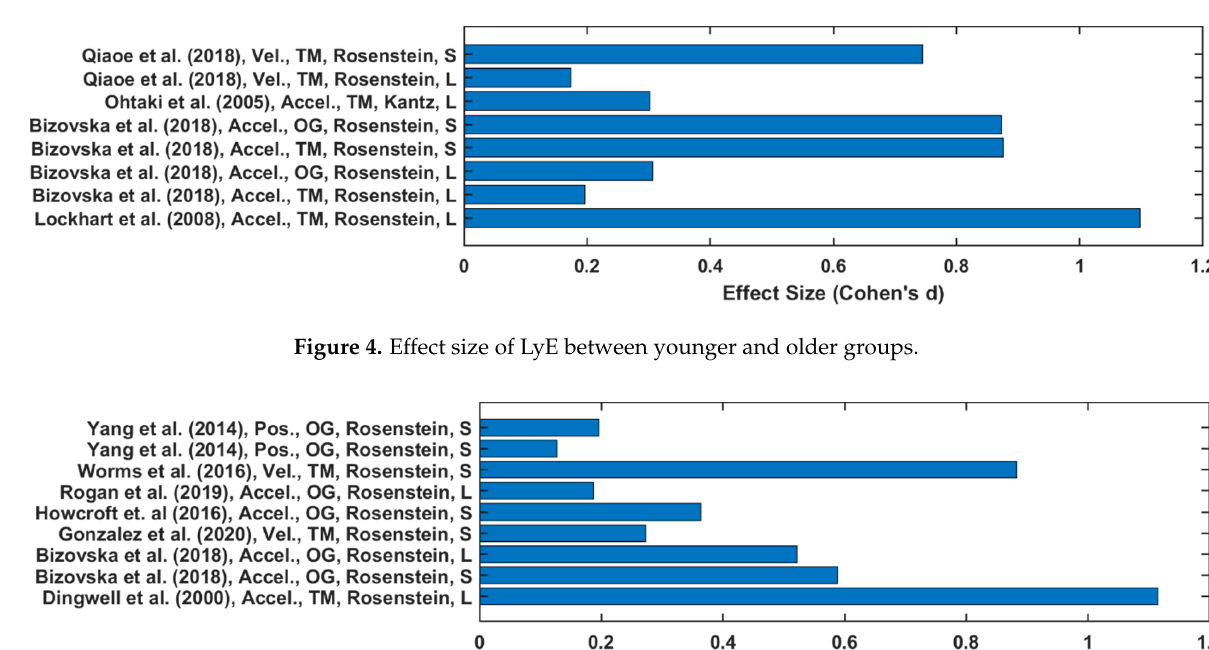
Figure 5. TM walking effect size (0.76 ± 0.43) is higher than OG walking (0.37 ± 0.19).